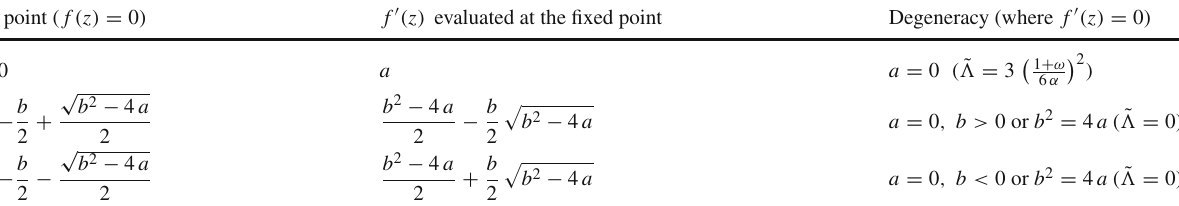
Table 4 Fixed points for dynamical system dz Fixed point ( f ( z ) = 0)